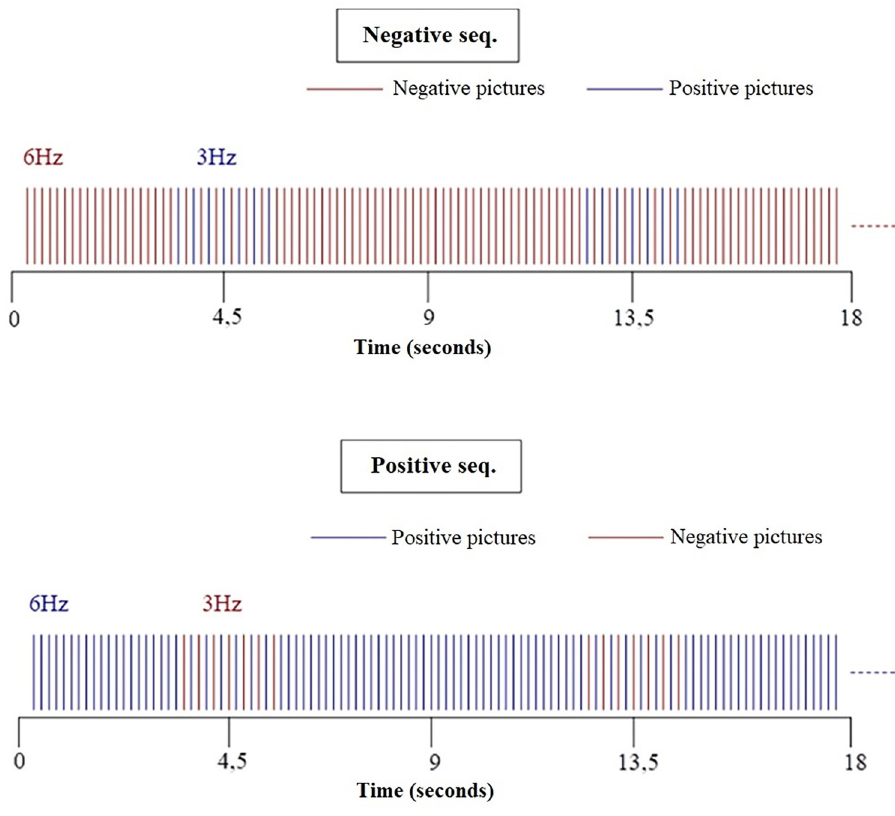
Fig 2. Emotional periodic oscillatory stimulation sequences